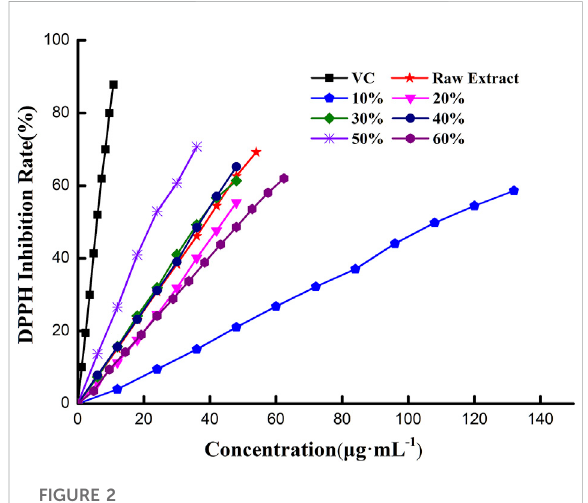
FIGURE 2 Scavenging activity of C. retusa leaf extract on DPPH free radical.